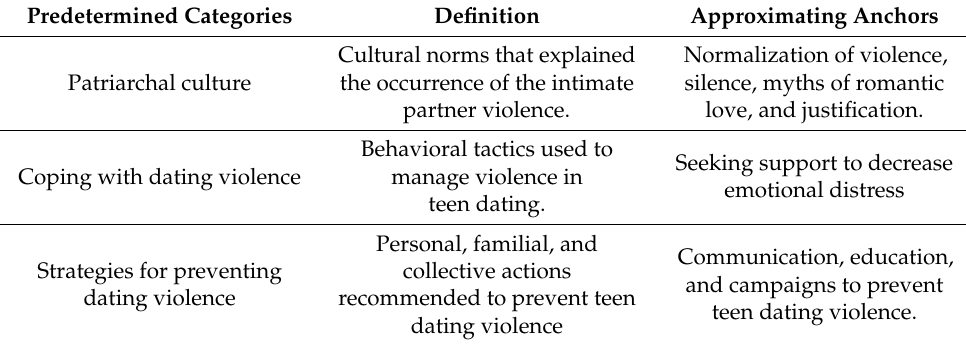
Table 1. Predetermined codes: Deductive